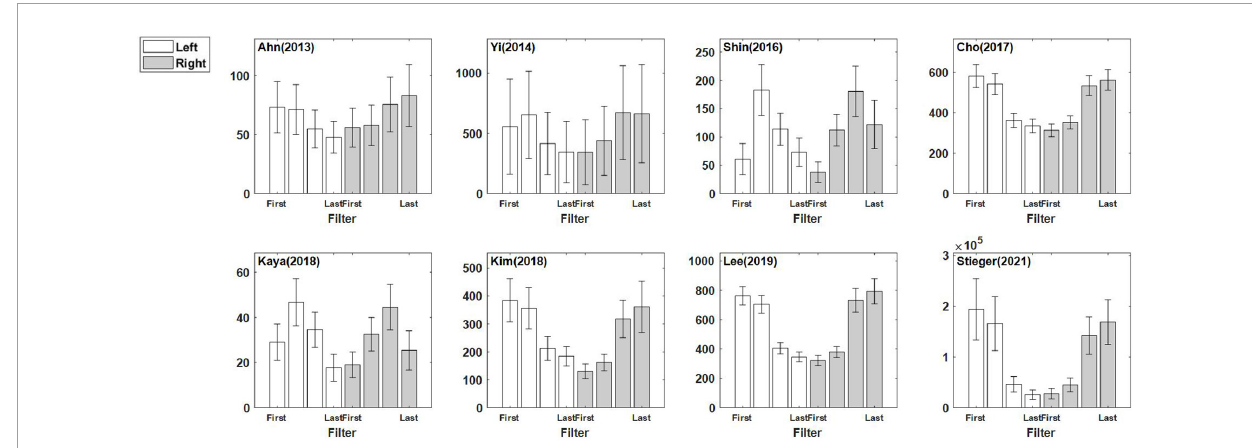
FIGURE4 Eight common spatial pattern features for each dataset. The four CSP filters were applied to left trials and right trials, and the eight features were concatenated. The presented features are the averaged features over all sessions/subjects in each dataset. Note that the first two CSP filters are designed to maximize the variance of left motor imagery trials, and the last two CSP filters does that for the right motor imagery trials. The error bar represents the standard error.